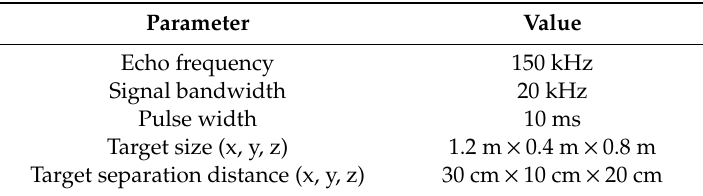
Table 2. Transducer array and cube target parameters.